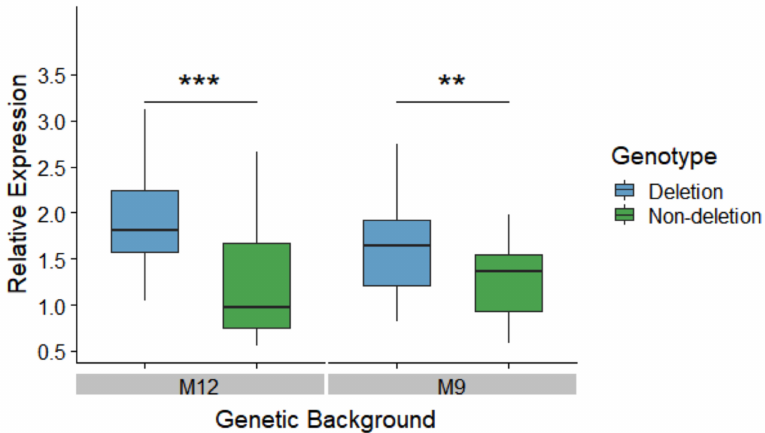
Figure 2. Effect of the indel polymorphism on MtnA expression in nearly-isogenic lines within two genetic backgrounds (M12 and M9) derived from Munich, Germany. Expression was measured in male heads by qRT-PCR using the ribosomal protein gene RpL32 as a reference. Differences in expression were tested with a two-factor ANOVA. ** P < 0.01, *** P <